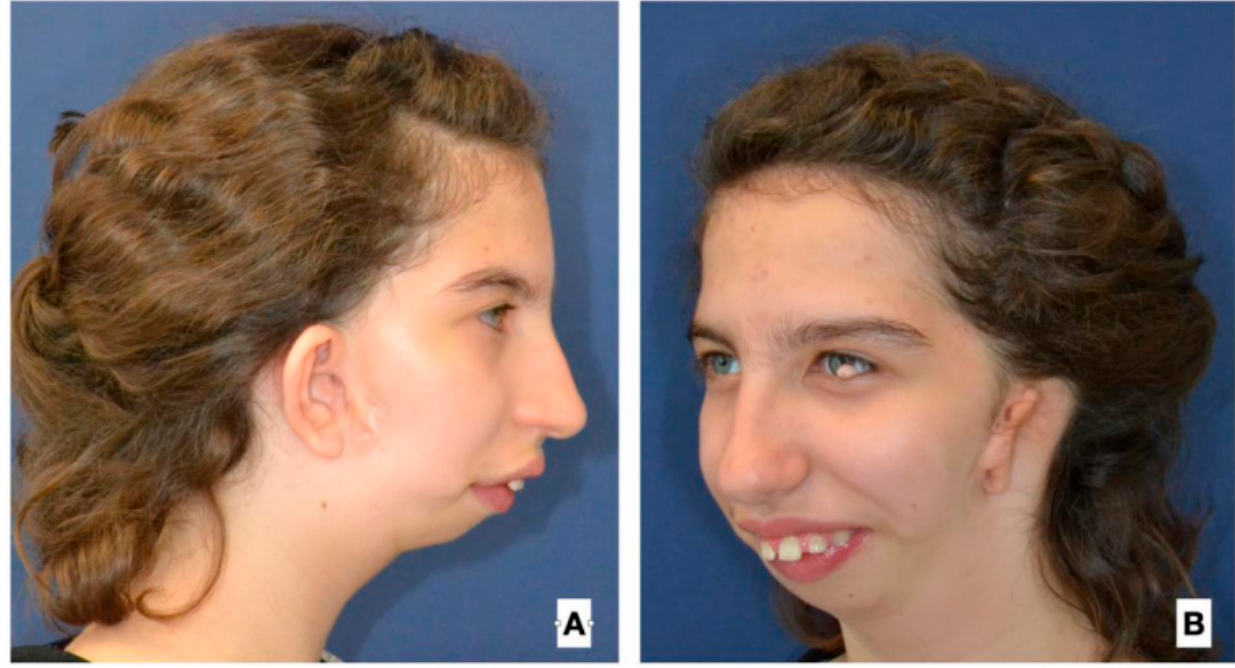
Figure 4. Patient aged 15 years with bilateral HFM. ( A ) Side view. ( B ) Three-quarter view.